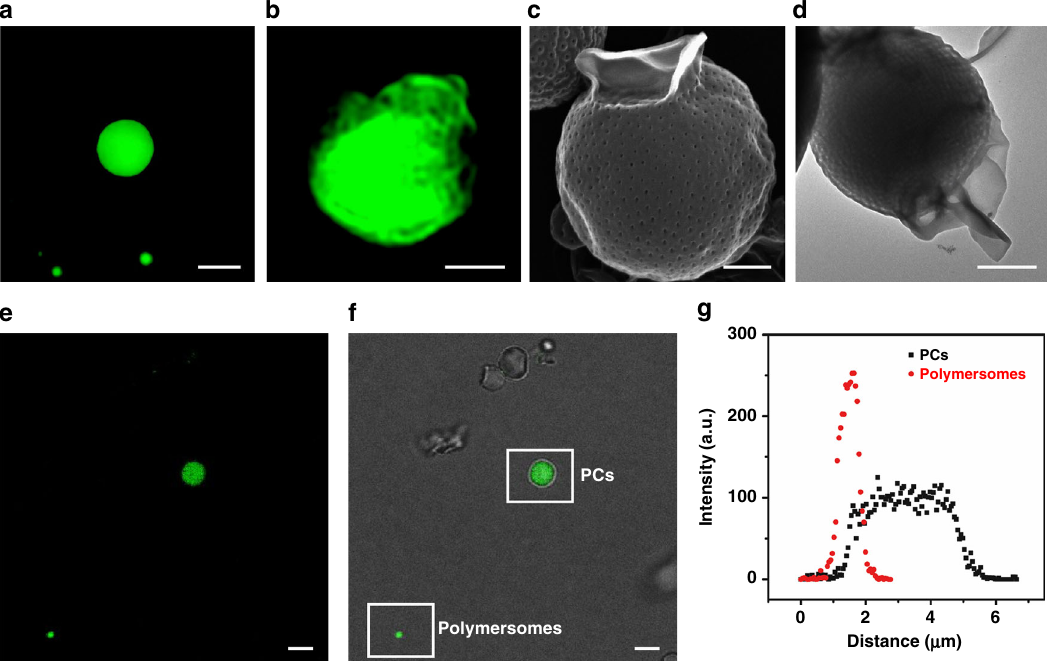
Fig. 5 Fusion of fl uorescein-encapsulating polymersomes and PCs. a SIM image showing the fusion product of polymersome/PC and free polymersomes. Scale bars are 2 μ m. b SIM image of fused PC showing deformed polymersomes tethered to the surface of the PC. Scale bar is 1 μ m. c , d SEM ( c ) and TEM ( d ) image showing the fusion of fl uorescein-encapsulating polymersomes and PCs. Scale bars are 500 nm. e , f CLSM images showing both fl uorescein- encapsulating polymersomes and PCs. The merged image ( f ) shows that only PCs fused with polymersomes retain fl uorescence. Scale bars are 5 μ m. g The Intensity pro fi le of CLSM images of fl uorescein-encapsulating polymersomes and PCs revealing the distribution of fl